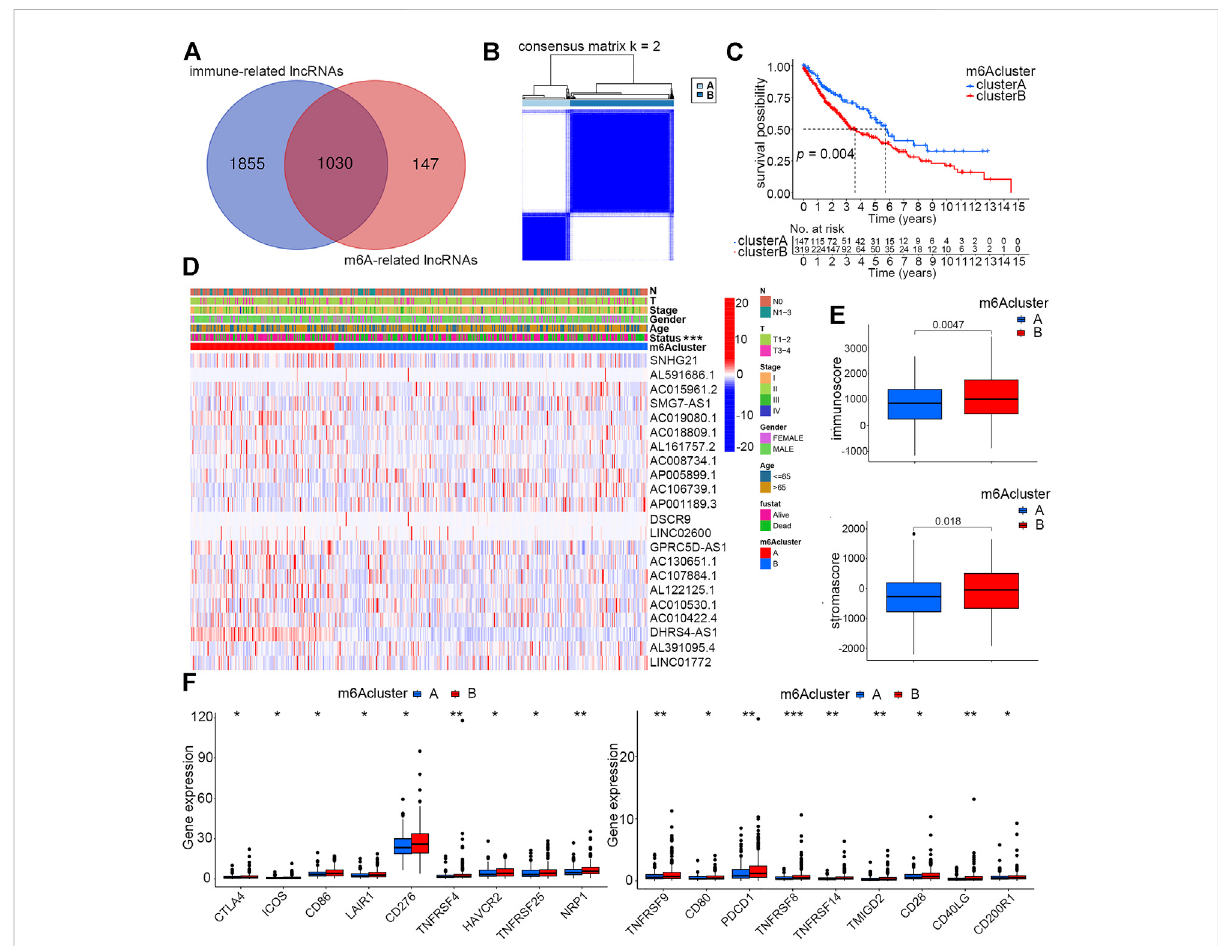
FIGURE 2 Identi fi cation of two distinct m6A clusters and differences of their clinical and immune features. (A) Identi fi cation of immune-related lncRNAs regulated by m6A regulators. (B) Two distinct m6A clusters were determined based on m6A-regulated immune-related lncRNAs via unsupervised consensus clustering analysis. (C) Overall survival differences between m6A clusters A and B by Kaplan – Meier survival analysis. Log-rank p = 0.004. (D) Differences of clinical features and expression pro fi les of m6A-regulated immune-related lncRNAs between clusters A and B (*** p < 0.001) (E) Differences of immune and stroma scores by ESTIMATE analysis of smoking-associated LUSC samples between m6A clusters A and B . (F) Differences of expression levels of immune checkpoint molecules between m6A clusters A and B (* p < 0.05, ** p < 0.01, and *** p <